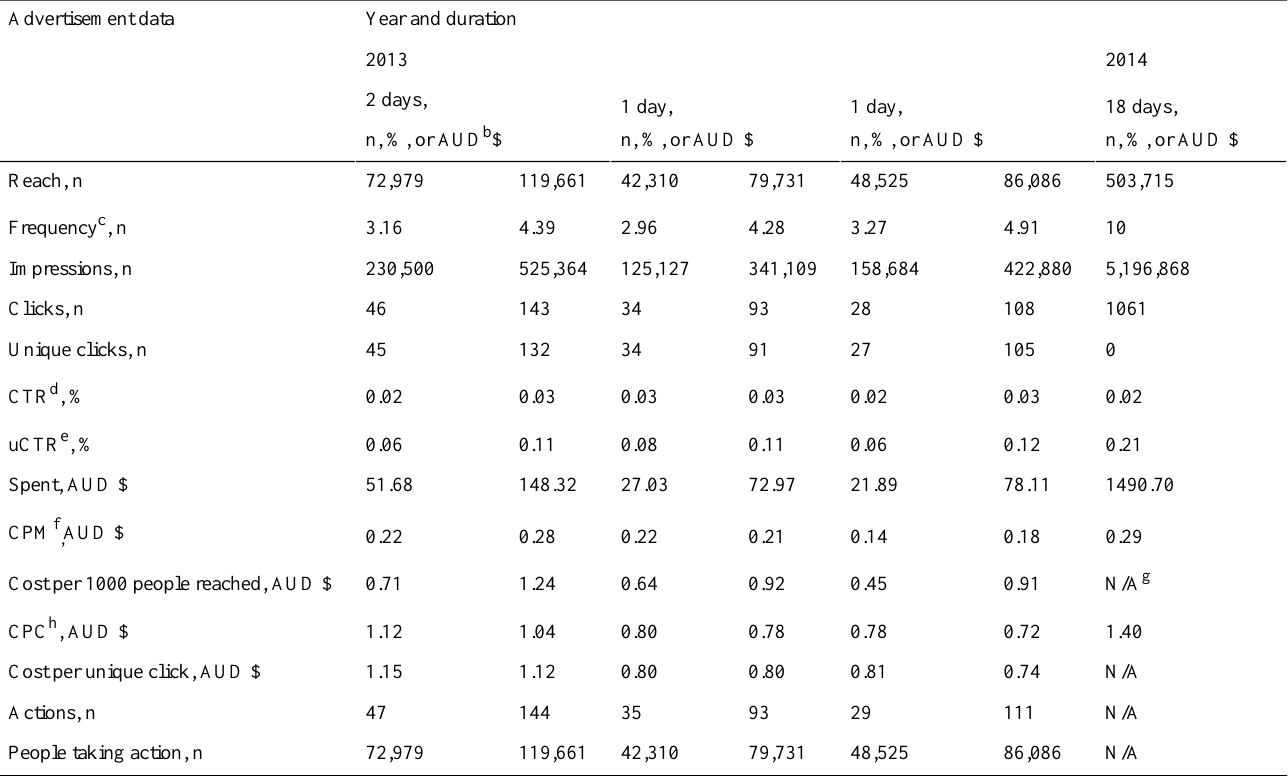
Table 3. Facebook TXT2BFiT advertisement data for website clicks on right-hand column advertisements on desktop computers over 4 days in 2013 and over 18 days in 2014 a